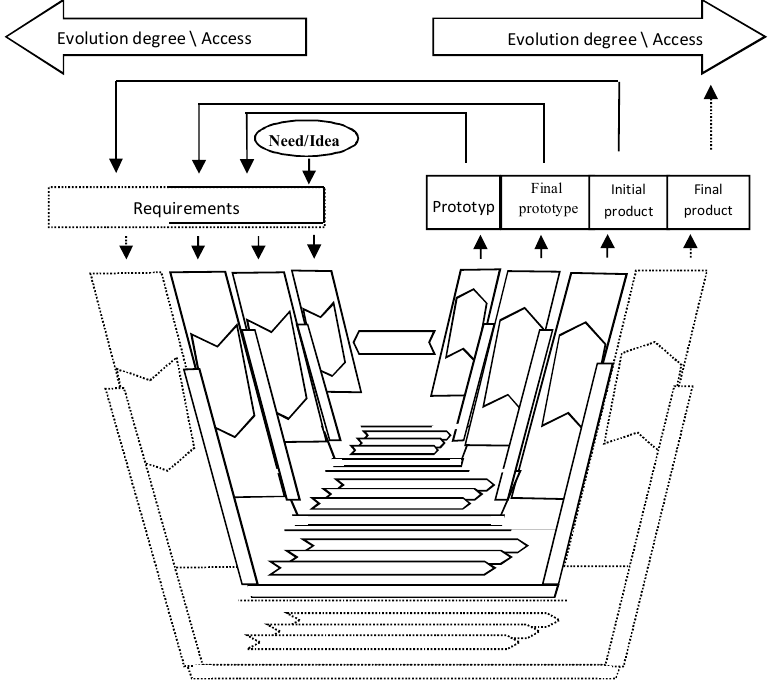
Fig 6 . Iterative loop of the model for design and development of the prototype (Gausmeier,